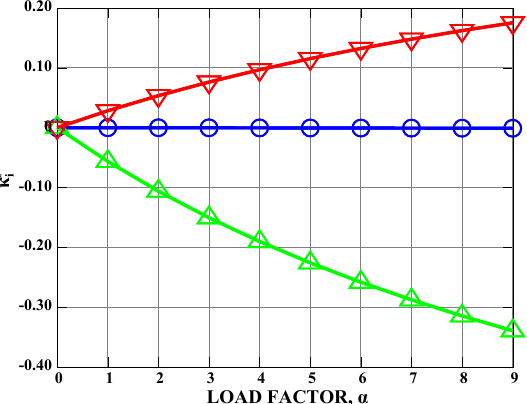
Figure 6. Components of the wryness vector: κ ∗ ( (cid:13) ), κ ∗ ( 4 ), κ ∗ ( 5 ). 1 2 3 Proposed deformation